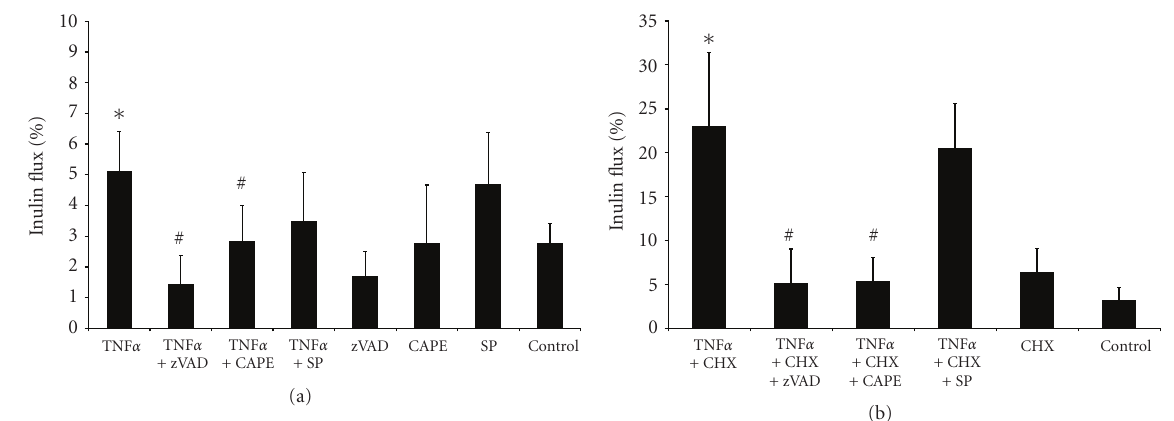
Figure 3: TNF α -induced increase of paracellular inulin flux in PCPEC is caspase- and NF- κ B-dependent. E ff ects of the pan-caspase inhibitor zVAD (10 μ M), the NF- κ B inhibitor CAPE (5 μ M), and the JNK-inhibitor SP600125 (10 μ M) on TNF α -induced increase of paracellular FITC-inulin flux in PCPECs were determined at 24 hours. The FITC-inulin flux was measured in the apical-to-basolateral direction with or without stimulation and is expressed as percentage of tracer in the basolateral compartment. PCPEC were stimulated apically with TNF α (100ng/mL) with (b) or without (a) cycloheximide (1 μ g/mL). The data shown are mean ± SEM of four independent experiments, each performed in duplicate. # P-value of < .05 compared to TNF α stimulated PCPEC without inhibitor; ∗ P-value of < . 05 compared to unstimulated PCPEC.